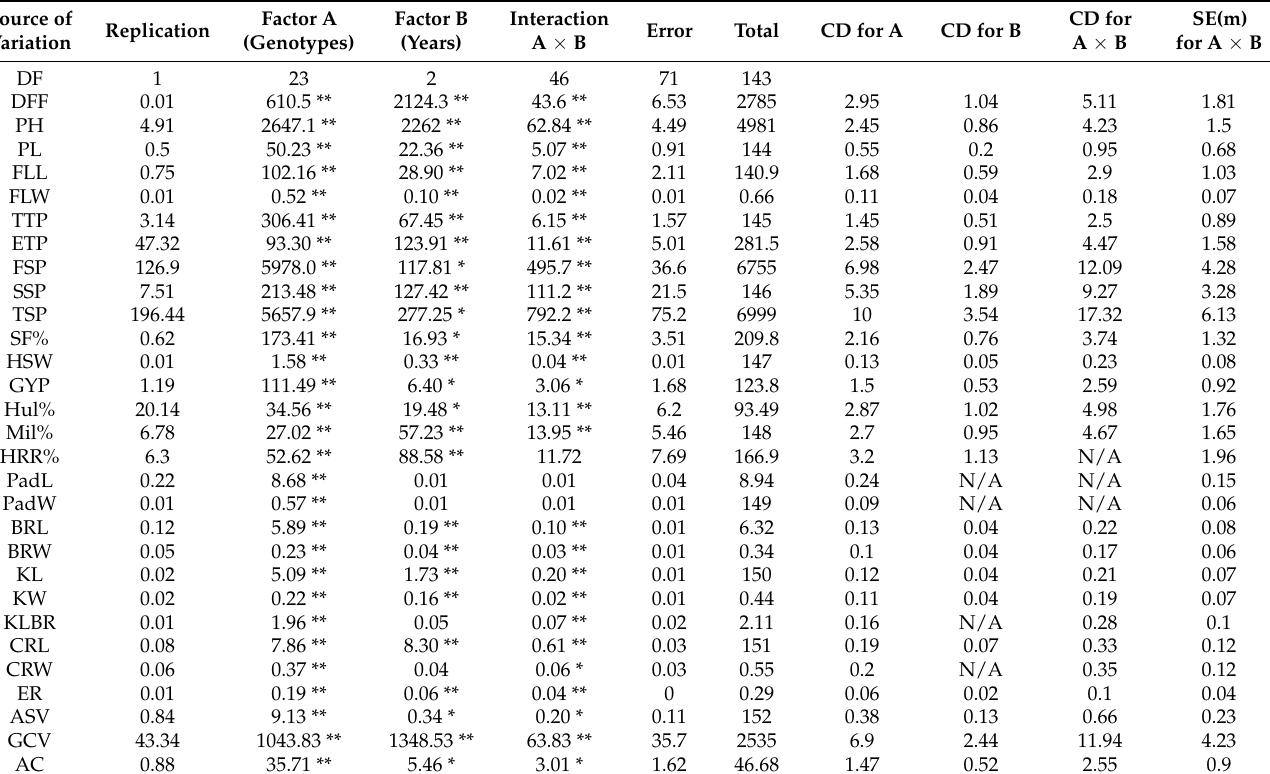
Table 3. Analysis of variance (ANOVA) for agro-morphological and grain quality traits based on Factorial Randomized Complete Block